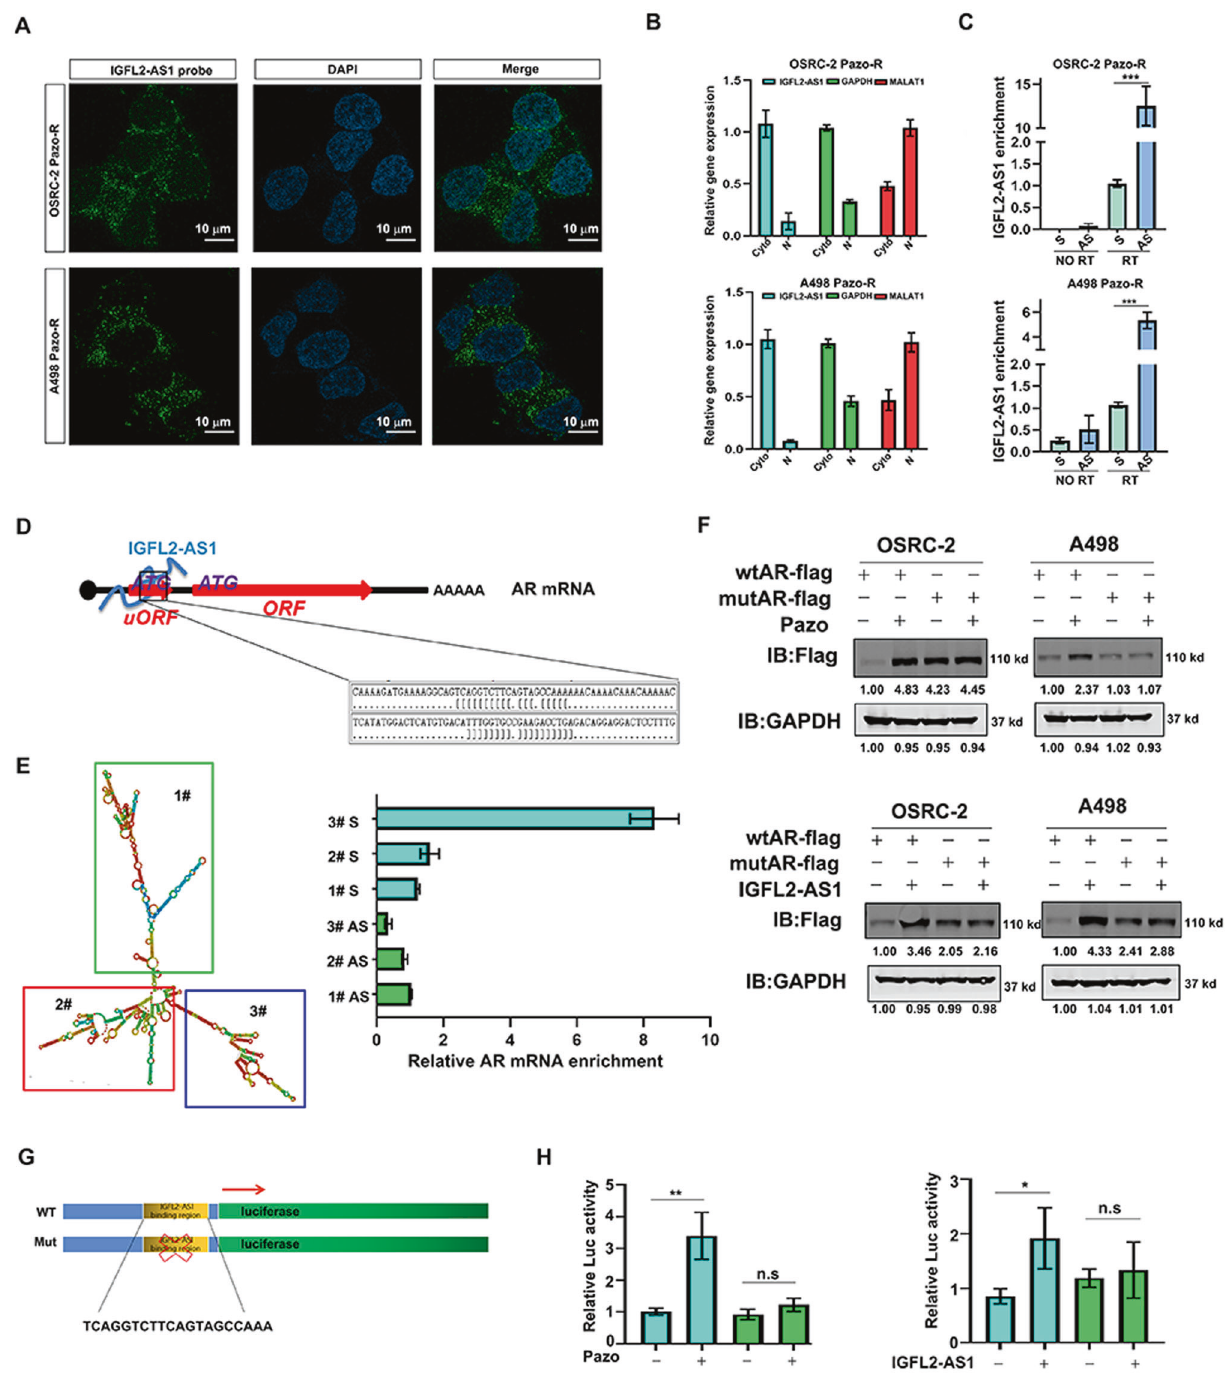
Fig. 3 IGFL2-AS1 regulates the uORF activity of AR mRNA and facilitates its translation. A FISH staining of IGFL2-AS1 in pazopanib resistant ccRCC cells. B Cyto-nuclear fraction separation to identify IGFL2-AS1 location. Cytoplasmic RNA: GAPDH; Nuclear RNA: MALAT1 . C RNA IP with 4 anti-sense probes against AR mRNA to detect IGFL2-AS1 enrichment. AS Anti-sense probe; S Sense probe. D Cartoon showing the interaction of IGFL2-AS1 and AR mRNA. E Left, RNA structure of IGFL2-AS1 predicted by RNAfold Webserver . Right, truncated mapping showed that fragment 3# containing AR binding motif interacted with AR mRNA. F Top, pazopanib treatment increased the expression of AR with wild type 5 ’ -UTR but not that with ATG de fi cient 5 ’ -UTR in both OSRC-2 and A498 cells. IGFL2-AS1 boosted the expression of AR with wild type 5 ’ -UTR but not that with ATG de fi cient 5 ’ -UTR in both OSRC-2 and A498 cells. GAPDH was internal control. G Cartoon showing how wild type and mutated AR 5 ’ -UTR bearing luciferase constructs were made. H Pazopanib and IGFL2-AS1 enhanced the activity of wild type AR 5 ’ -UTR bearing luciferase but not that of mutated one in OSRC-2 cells. * P < 0.05; ** P < 0.01; *** P < 0.001, n.s = no signi fi cance.